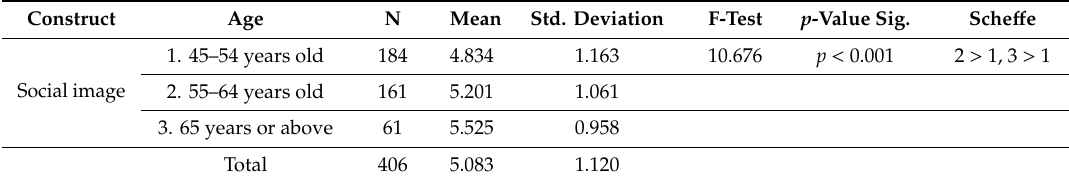
Table 3. Age vs. Social image research construct analysis of variance